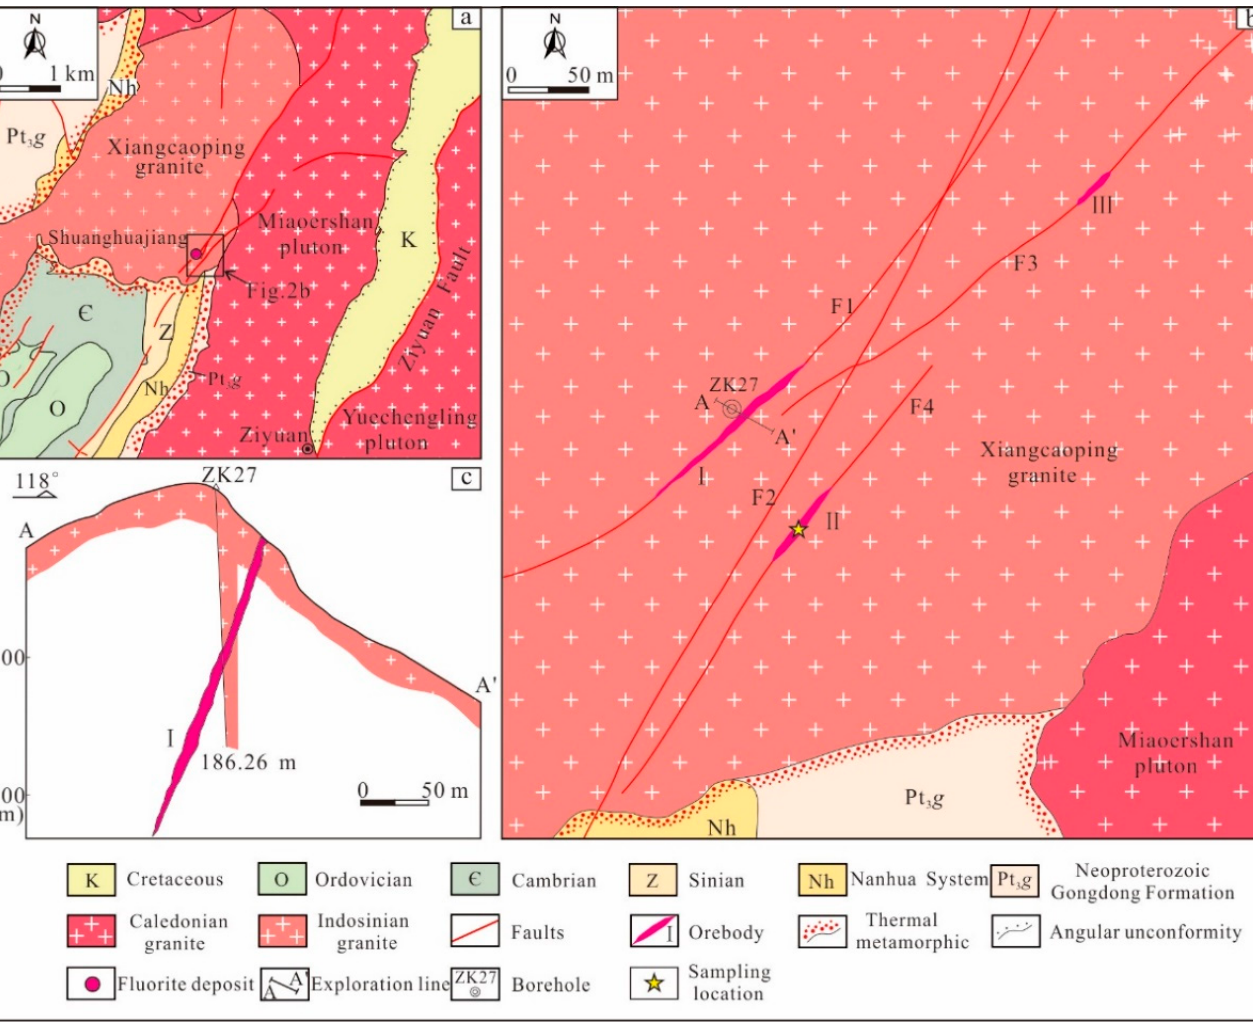
Figure 2. ( a ) Geologic map of the Miaoershan region; ( b ) geologic map of the Shuanghuajiang fluorite deposit; ( c ) cross-section of No. 10 exploration line . deposit; ( c ) cross-section of No. 10 exploration